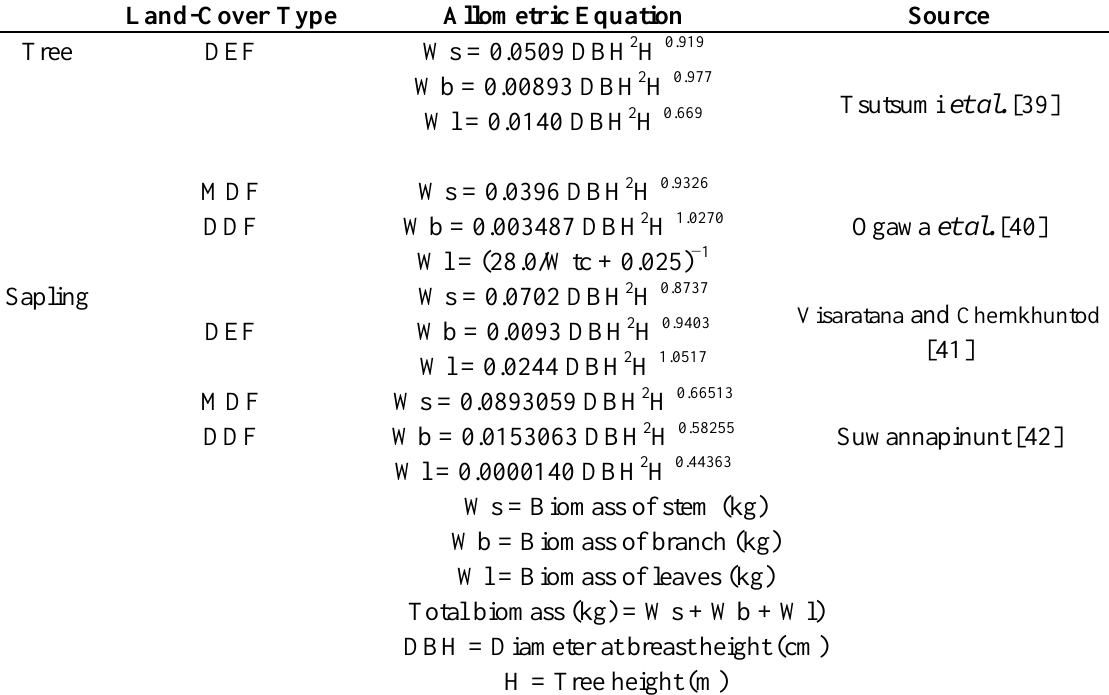
Table 1. Equations used for above-ground biomass (AGB) assessment.